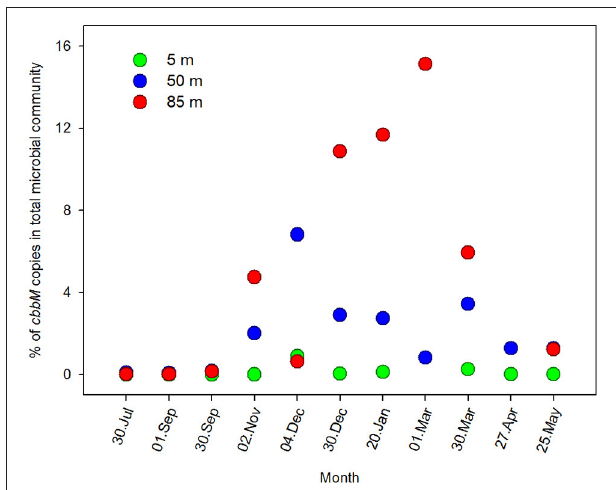
FIGURE 6 | Percentage of N ◦ of copies cbbM mL − 1 in the total microbial community. The N ◦ of copies for each depth were normalized with the microbial abundance, measured by flow cytometry, during an annual cycle at; 5, 50, and 85m of depth in Station 18.